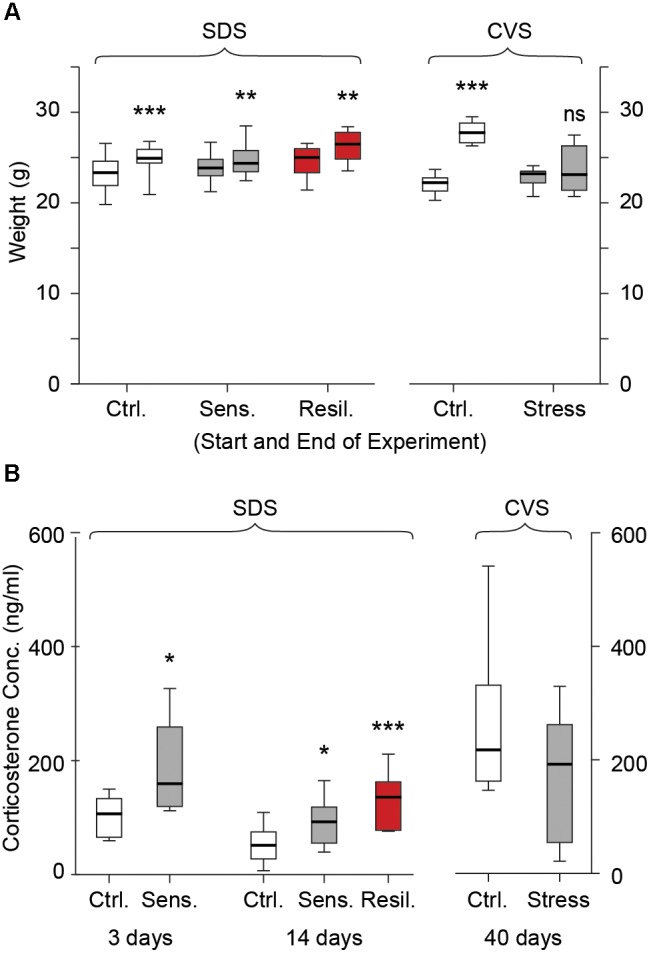
Weight gain and plasma corticosterone levels. (A) Box whisker plots show weight gain in the SDS and CVS paradigm. No differences were seen between the groups in the SDS paradigm at the start or end of the paradigm (p > 0.05). All groups showed a significant increase in weight gain during the 14 days (p < 0.001 for control and p < 0.01 for sensitive and resilient groups, Two-way ANOVA, n = 14, 12, and 6 for control, stress sensitive and stress resilient groups respectively). No significant difference was seen between the control and stress mice at the beginning of the CVS paradigm. After 40 days, control mice showed a significant increase in weight gain while no change in weight gain was seen for stressed mice (NS p > 0.05, ∗∗∗p < 0.001, Two-way ANOVA, n = 12, 11 for the control and stress mice respectively). (B) Plasma concentrations on day 3 and 14 of SDS, and day 40 of CVS. Stress mice had increased plasma corticosterone levels compared to controls after 3 days of social defeat (p < 0.05, Student’s t-test, n = 6 per group). Both stress sensitive and stress resilient mice showed a significant increase in plasma corticosterone levels compared to control after 14 days (p < 0.05 for sensitive, p < 0.001 for resilient groups, Tukey multiple comparison test, n = 14, 12, and 6 for control, stress sensitive and stress resilient groups respectively). No significant difference was seen in corticosterone levels after the CVS paradigm between stressed and control mice. (p > 0.05, Student’s t-test, n = 6 per group).